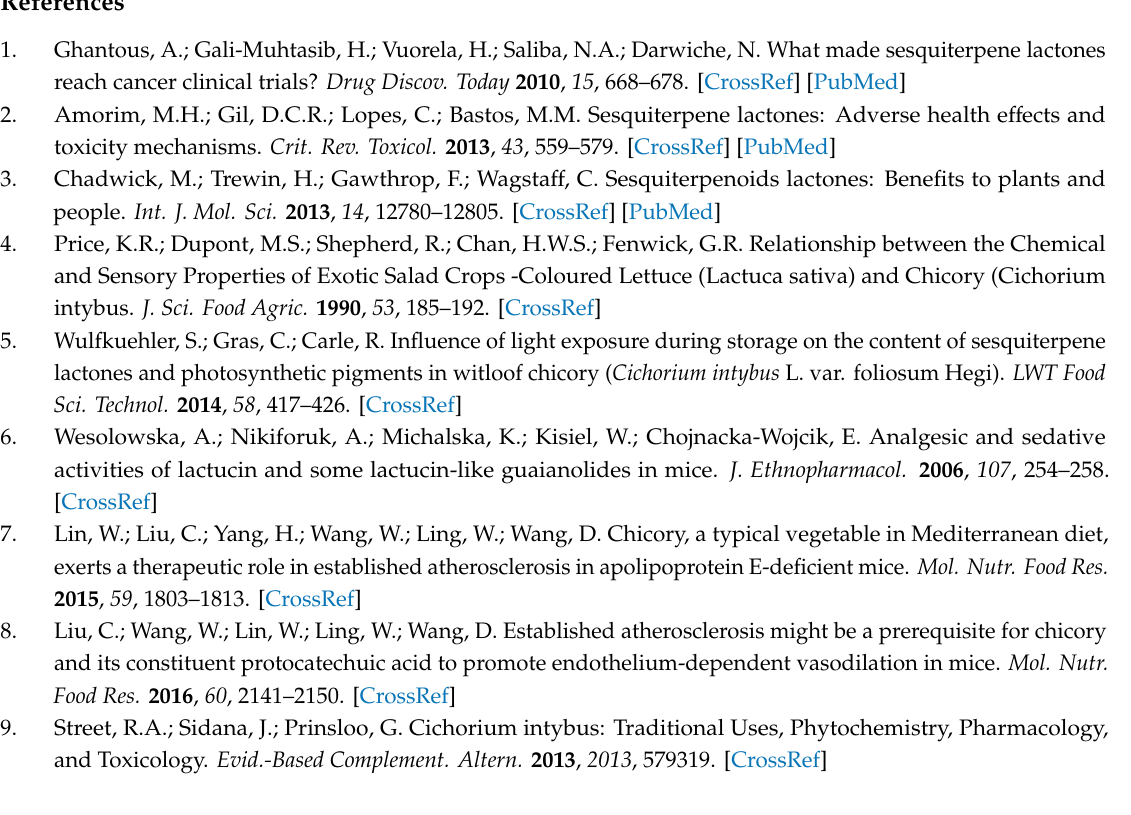
Figure S1: Characterization of sesquiterpene lactones in serum after Brussels / witloof chicory consumption, representative chromatographic profiles of ( A ) glucuronidated, ( B ) sulfated or ( C ) glycosylated sesquiterpene lactones in human serum sample collected at 1 h after the consumption of Brussels / witloof chicory. LAC, lactucin; DLAC, 11 β ,13-dihydrolactucin; IS, internal standard, Figure S2: Characterization of sesquiterpene lactones in urine after Brussels / witloof chicory consumption, representative chromatographic profiles of ( A ) glucuronidated, ( B ) sulfated or ( C ) glycosylated sesquiterpene lactones in human urine sample collected at 2–6 h after the consumption of Brussels / witloof chicory. LAC, lactucin; DLAC, 11 β ,13-dihydrolactucin; IS, internal